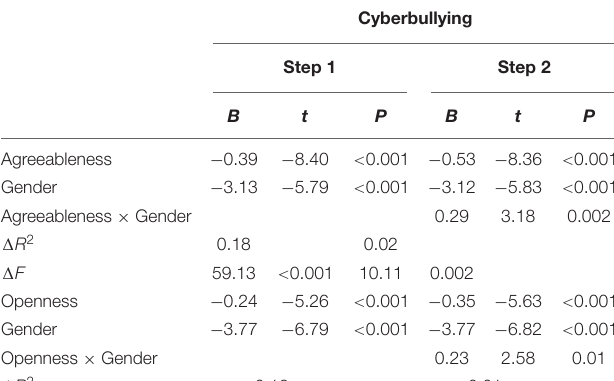
TABLE 3 | The moderating effect of gender.